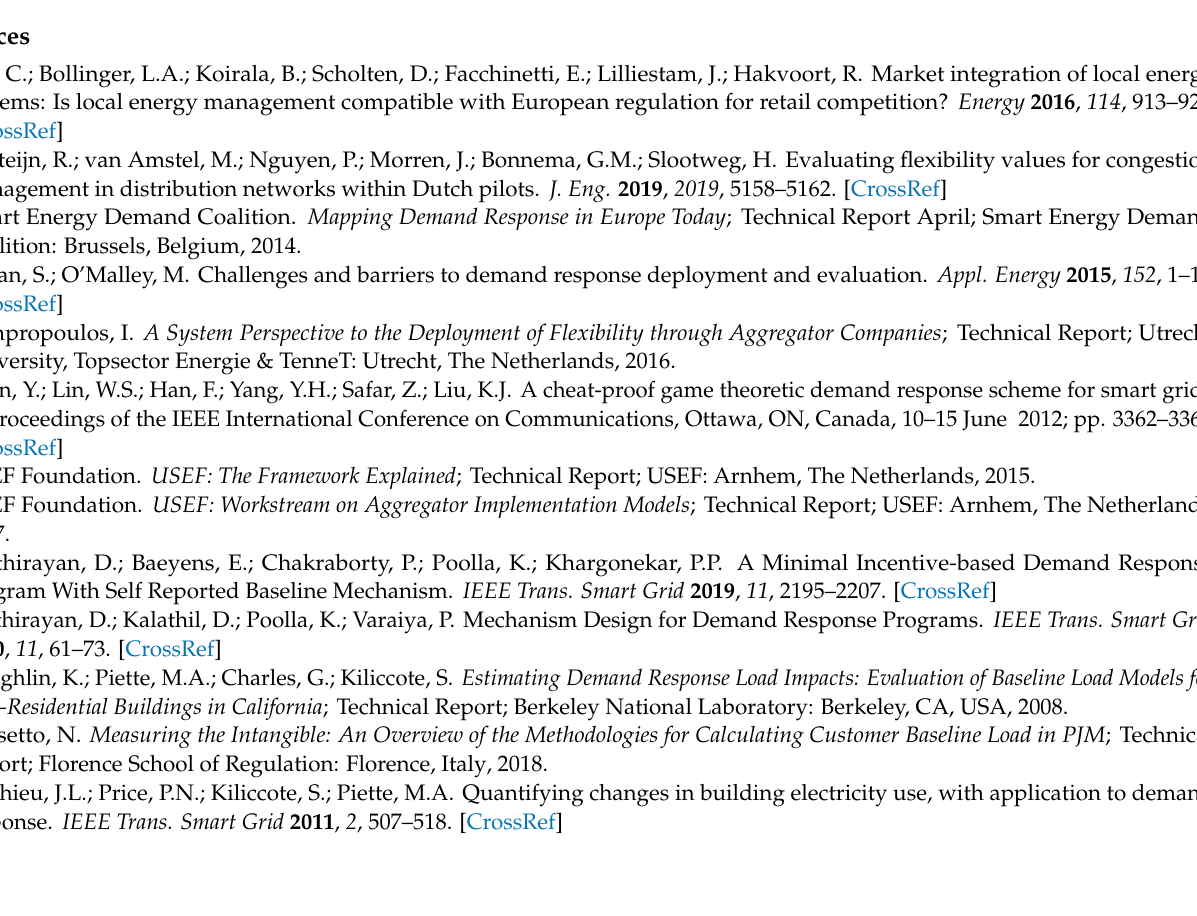
As discussed in Section 4.5, the performance of method III strongly depends on historical measurements. In periods of stable weather, method III generally outperforms method II, while method II and III perform relatively similar in case the historical irradiance is less stable. This can also be seen in Table A1. Similar to the results from Table 3, Table A1 shows method IV overall performs best, compared to methods I, II and III. The error of method IV is in all simulated weeks improved compared to the traditional baselining